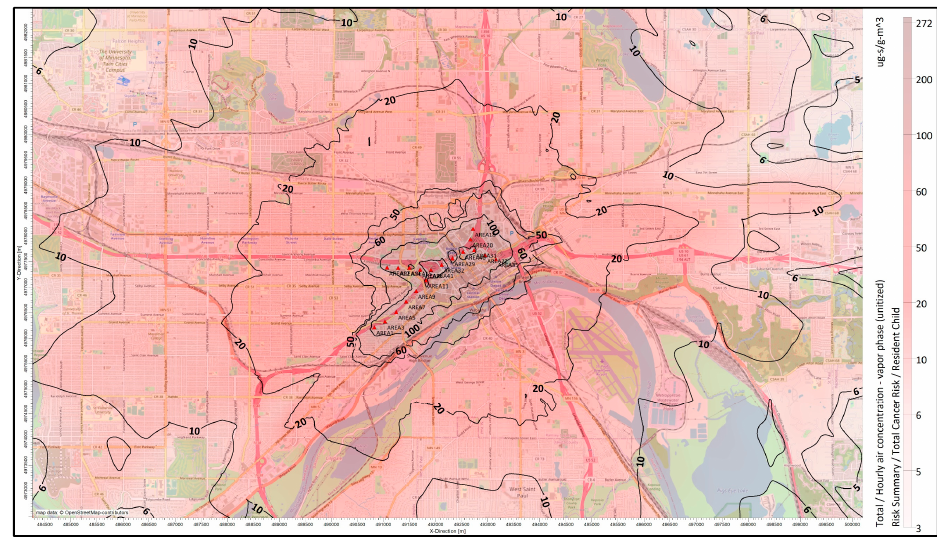
Figure 7. Formaldehyde Hourly Air Concentration—Vapor Phase (Unitized) Contour Plot overlaid on OpenStreetMap Satellite Imagery (OpenStreetMap, n.d.). Unit used in contour is µg-s/g-m 3 . In Figure 7, the maximum air concentration value is 271.8 µg-s/g-m 3 . Similar to ben- zene, high concentrations were located near the project’s center. The unitized annual av- erage air concentrations from the vapor phase ground-level air dispersion pattern are shown in Figure 8.